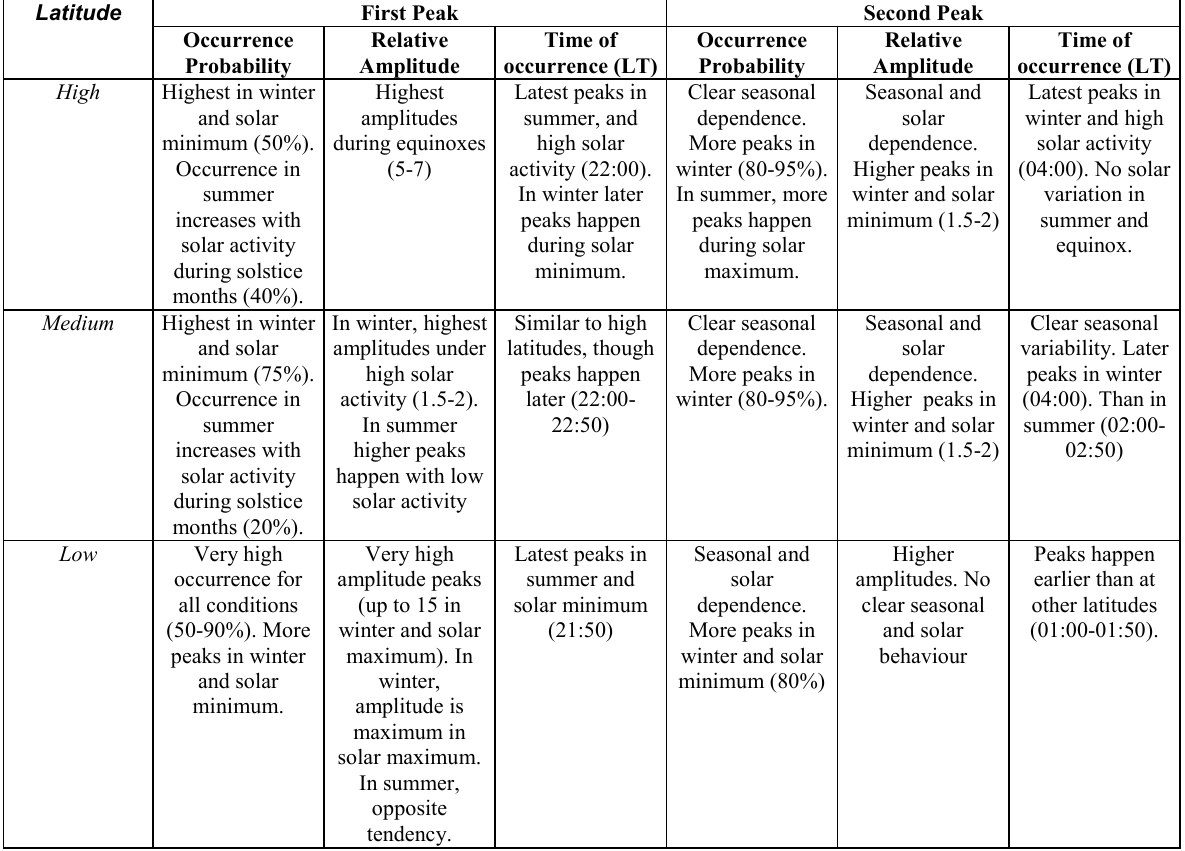
Table 3. Summary of